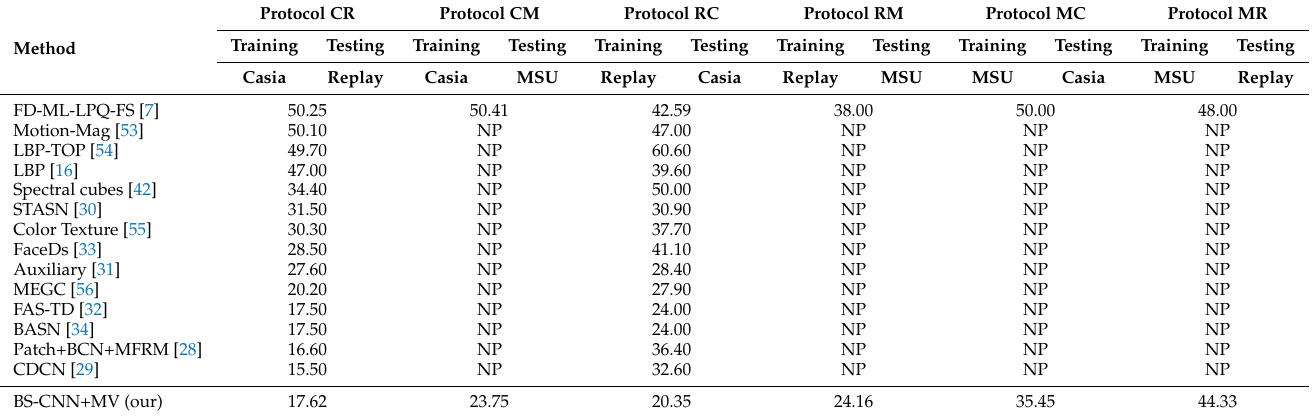
Table 7. The results of cross-dataset testing among CASIA-FASD, MSU-MFSD, and Replay-Attack. The evaluation metric is